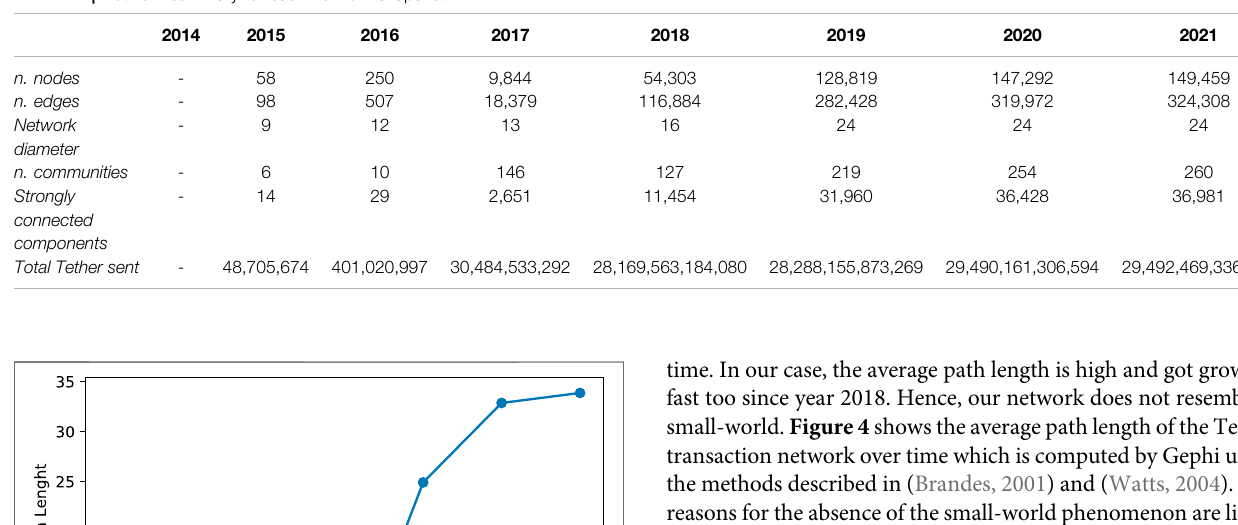
TABLE 1 | Network summary for each network snapshot.